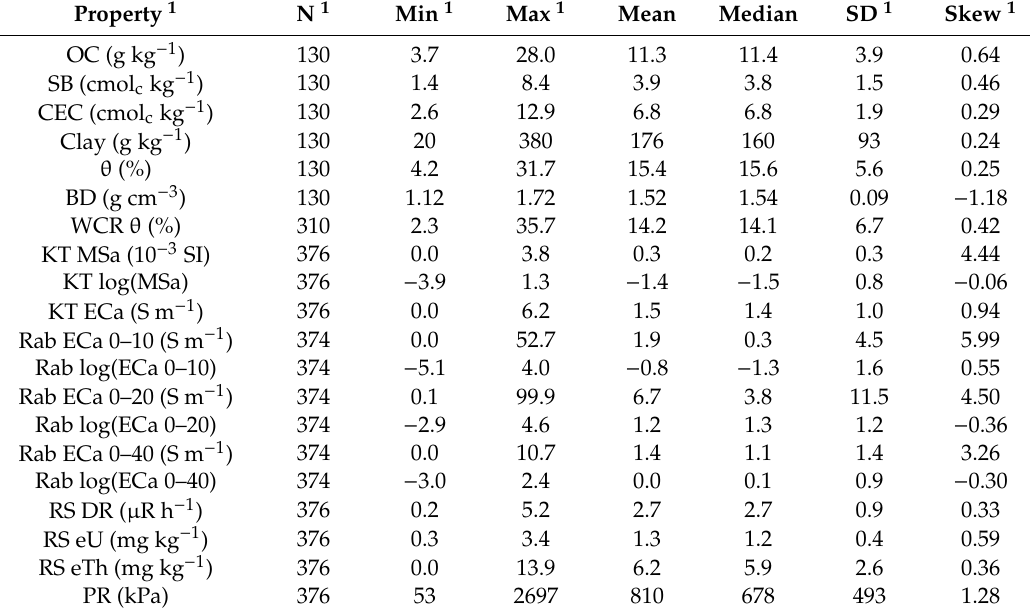
Table 1. Descriptive statistics of laboratory-measured, and field proximally-sensed soil properties. Property